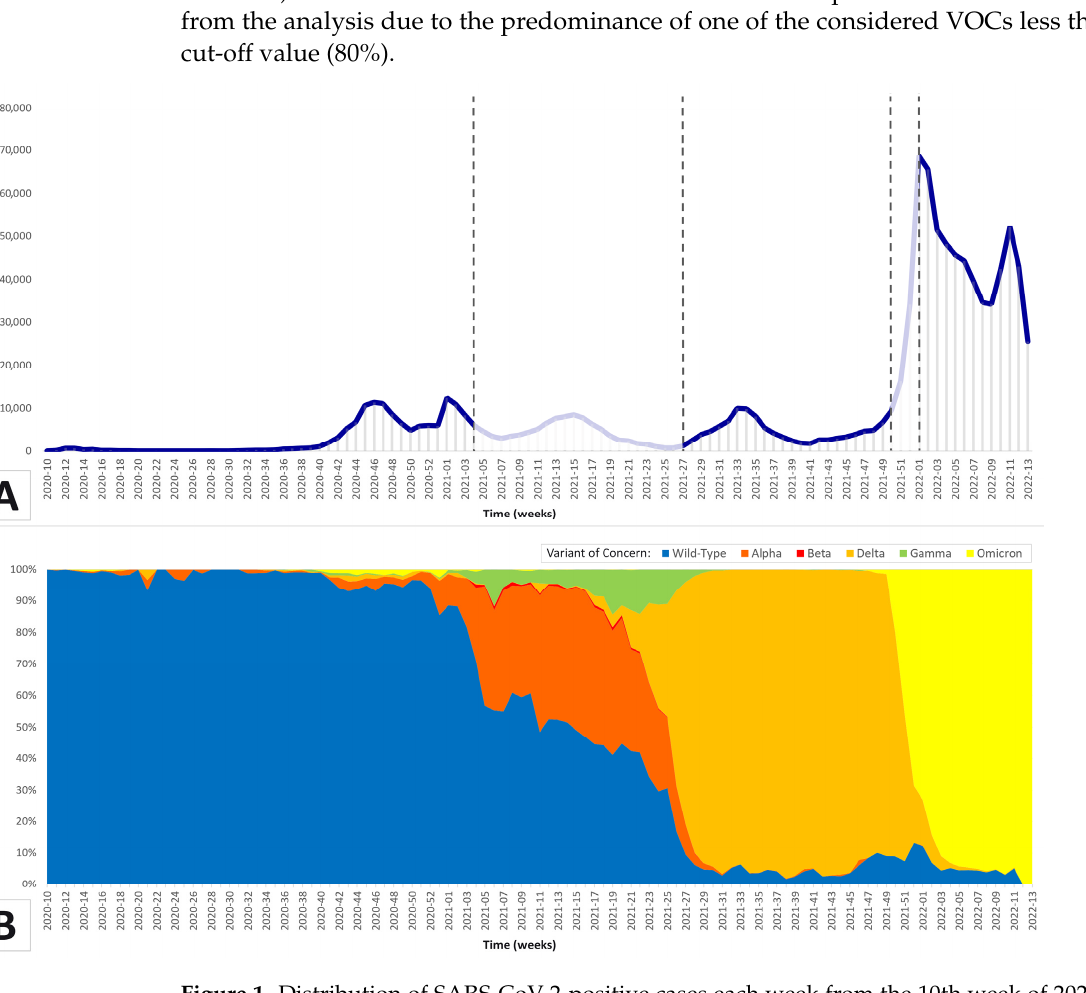
Gamma variants were never predominant, and, consequently, they were excluded from the analyses since it was not possible to assess their involvement in the development of a worse clinical scenario derived from SARS-CoV-2 infection. 3.3. Multivariable Analyses In Figure 2, three different multivariable logistic regression analysis models are reported with different outcomes: mild COVID-19 or worse (Model A); severe COVID-19 or worse (Model B); and intubation/death (Model C).